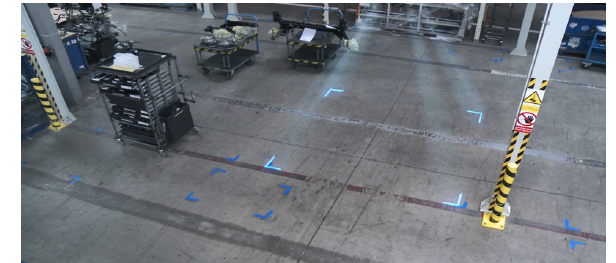
Figure 5: Marking of the place for allocation of the